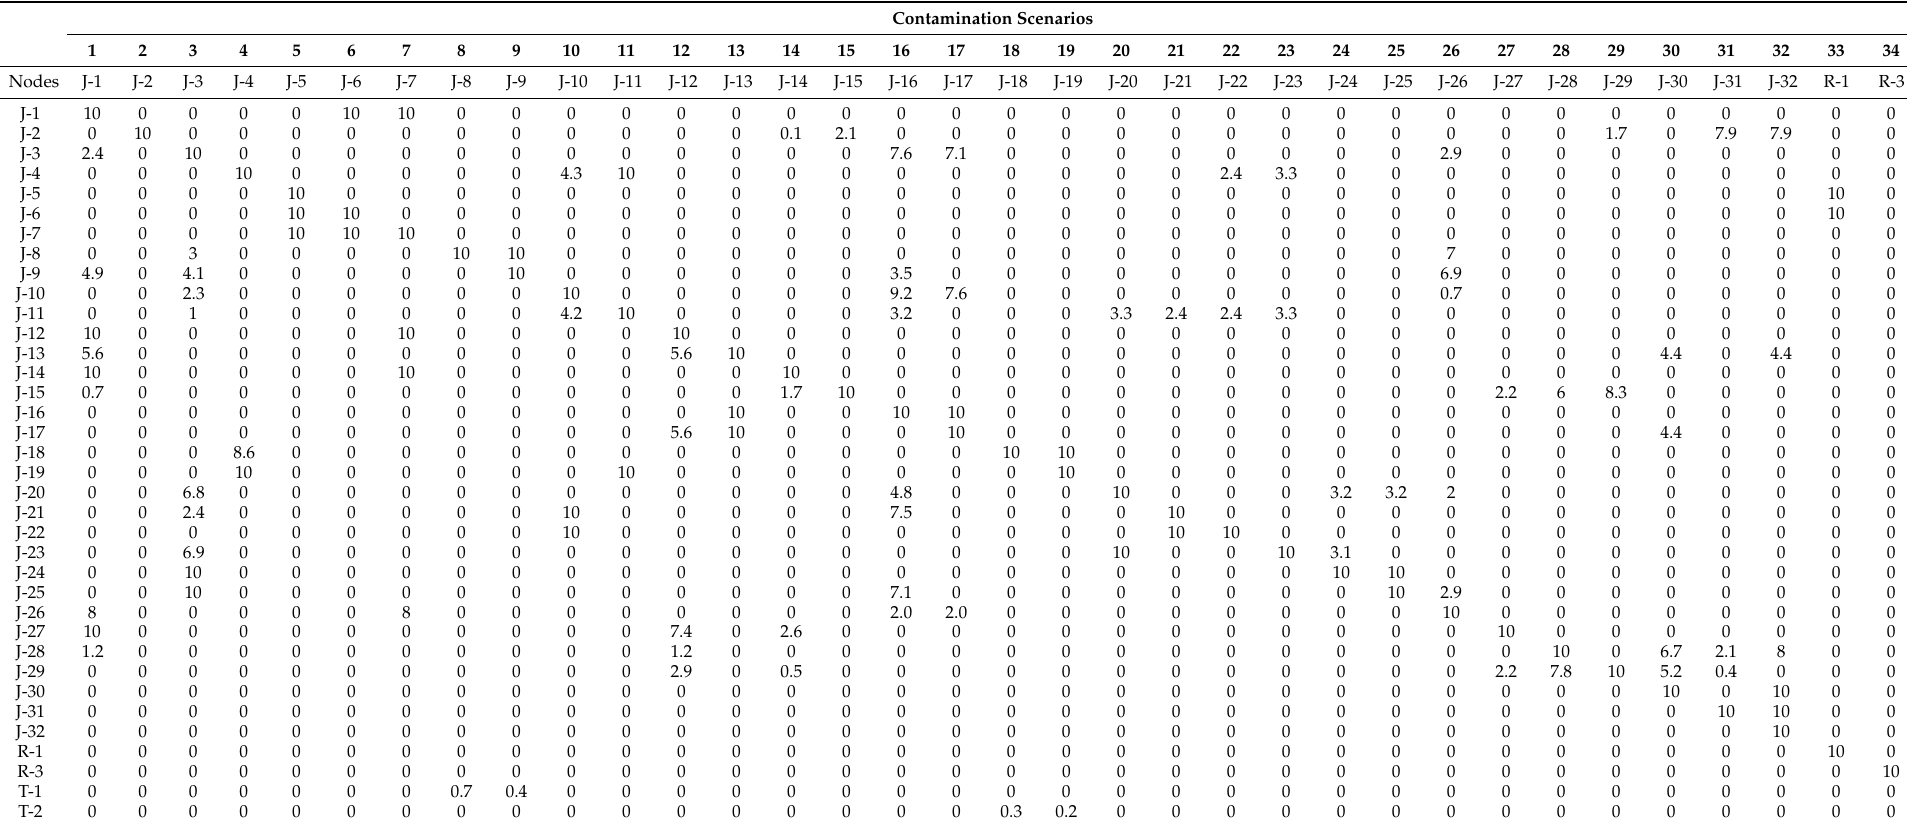
Table 1. Contaminant concentrations (mg/L) at each node for all contamination scenarios at injection time